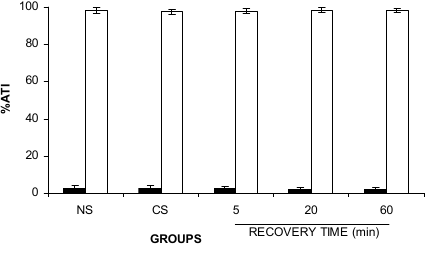
Data of the ATI% on P and BCs in Figure 5 suggest no significant alteration ( p > 0.05) to the distribution of the 99m Tc between the cellular and plasma compartments after recovery from FS.